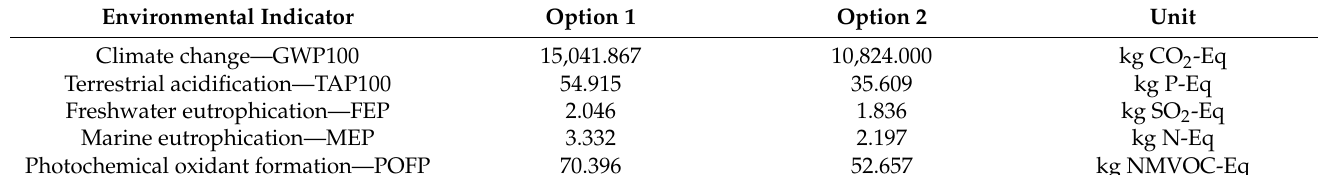
Table 7. Results of environmental loads for both houses (traditional and non-traditional).